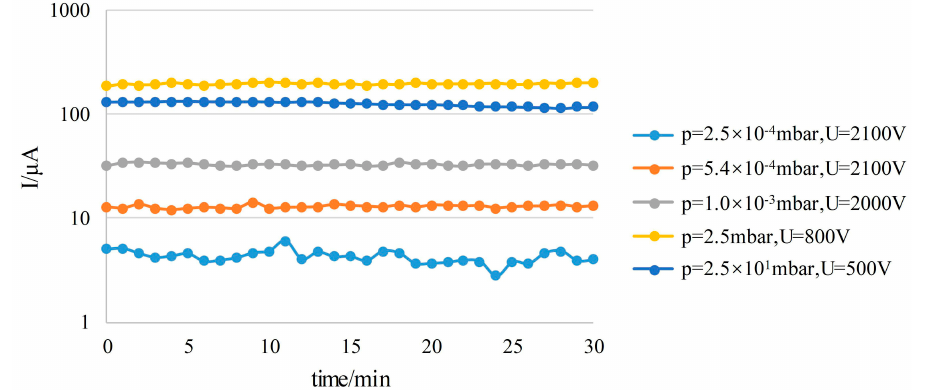
Figure 8. The stability of the ion source operation.